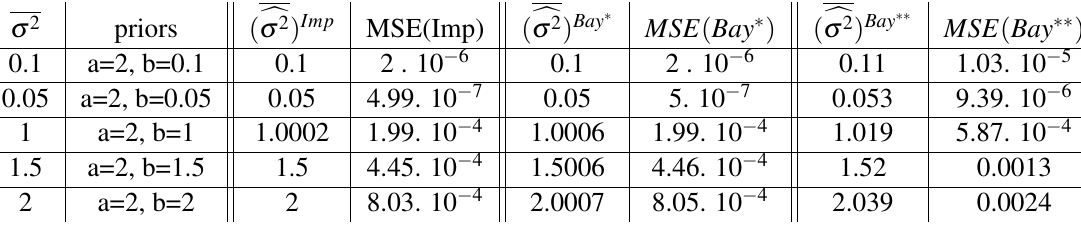
Table 1: Estimators of σ 2 obtained by Implicit method, Bayesian method with true a priori ( Bay ∗ ) and different one ( Bay ∗∗ ), for several prior parameters ( a and b ) and σ 2 .